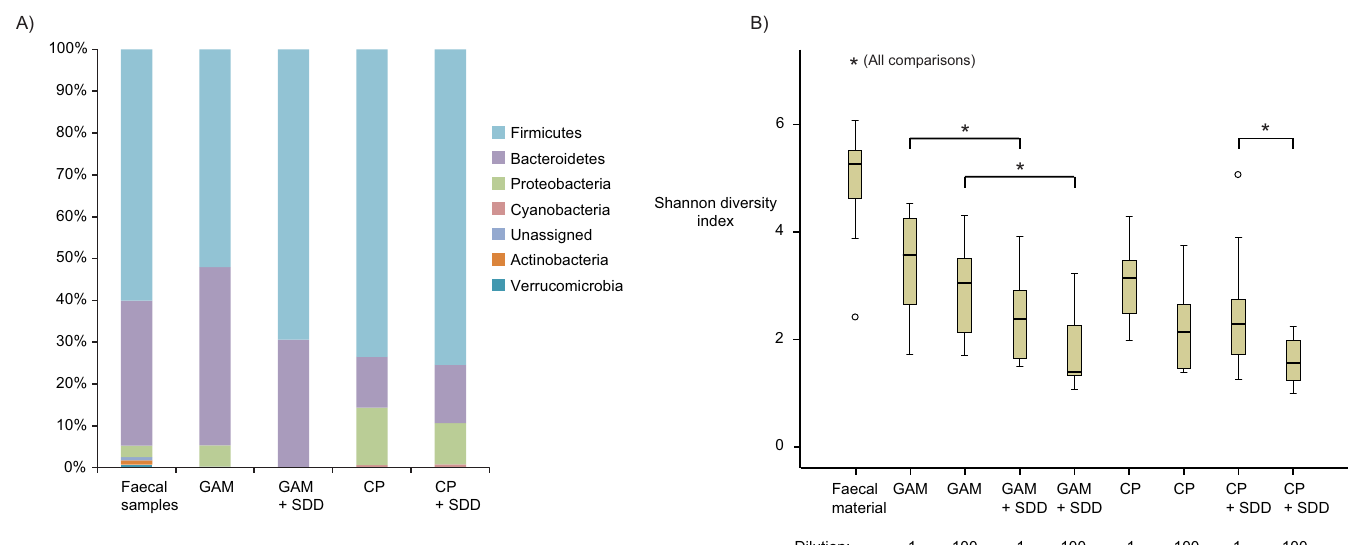
Fig 2. Diversity of the bacterial communities. A) Bacterial phyla that were detected in the faecal samples of 20 intensive care patients and in their corresponding growth communities on GAM and CP agar media. Growth on these media was further subdivided based on the addition of the SDD antibiotics. Phyla with a relative abundance < 0.5% are not shown. The relative abundance values are based on the combined reads of all samples in the different experimental groups. B) Boxplots depicting the distribution of Shannon diversity values of bacterial communities in the different experimental groups. Asterisks indicate that Shannon values of bacterial communities in experimental groups were significantly different ( p = < 0.05) based on the two-tailed t-test. Medium (i.e. GAM vs. CP) did not significantly affect Shannon values of bacterial growth communities.